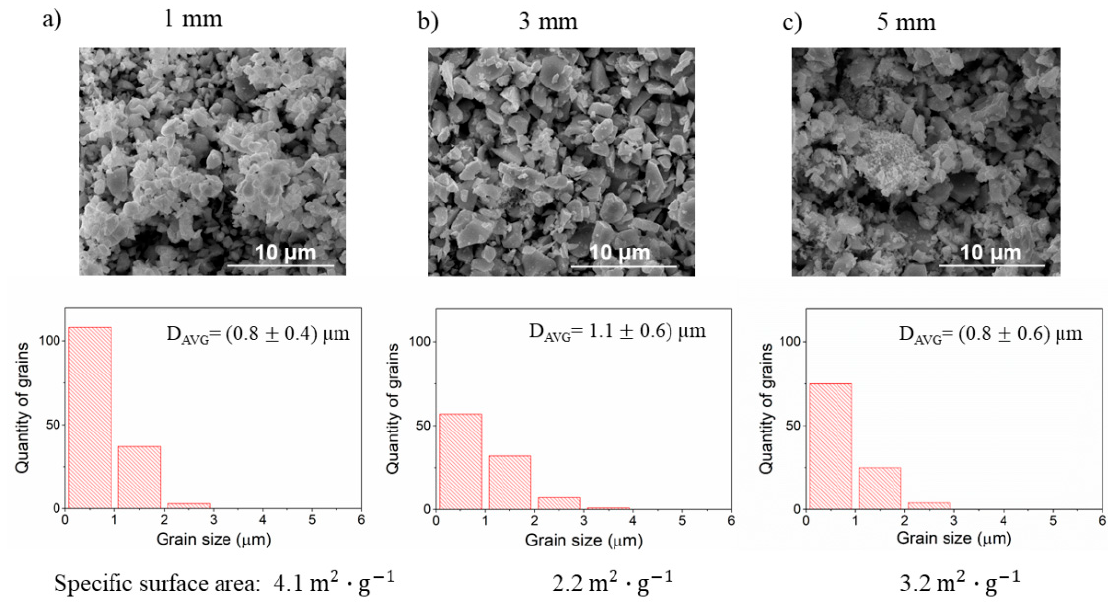
Figure 9. The SEM images with grain size analysis and specific surface area of the BLCF powders milled with ( a ) 1 mm, ( b ) 3 mm and ( c ) 5 mm balls.